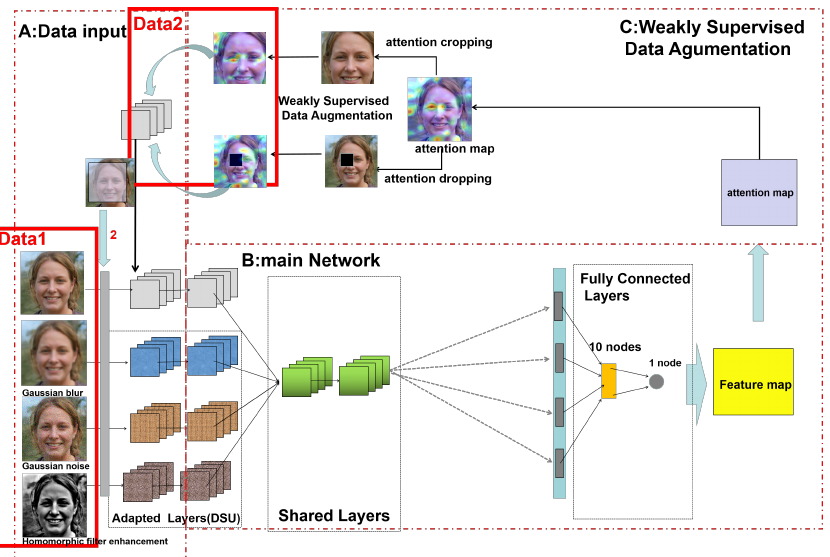
Figure 5. The process of data augmentation and preprocessing. In this figure, the fake face is from the open source StyleGAN dataset and the real face is from the open source FFHQ dataset.